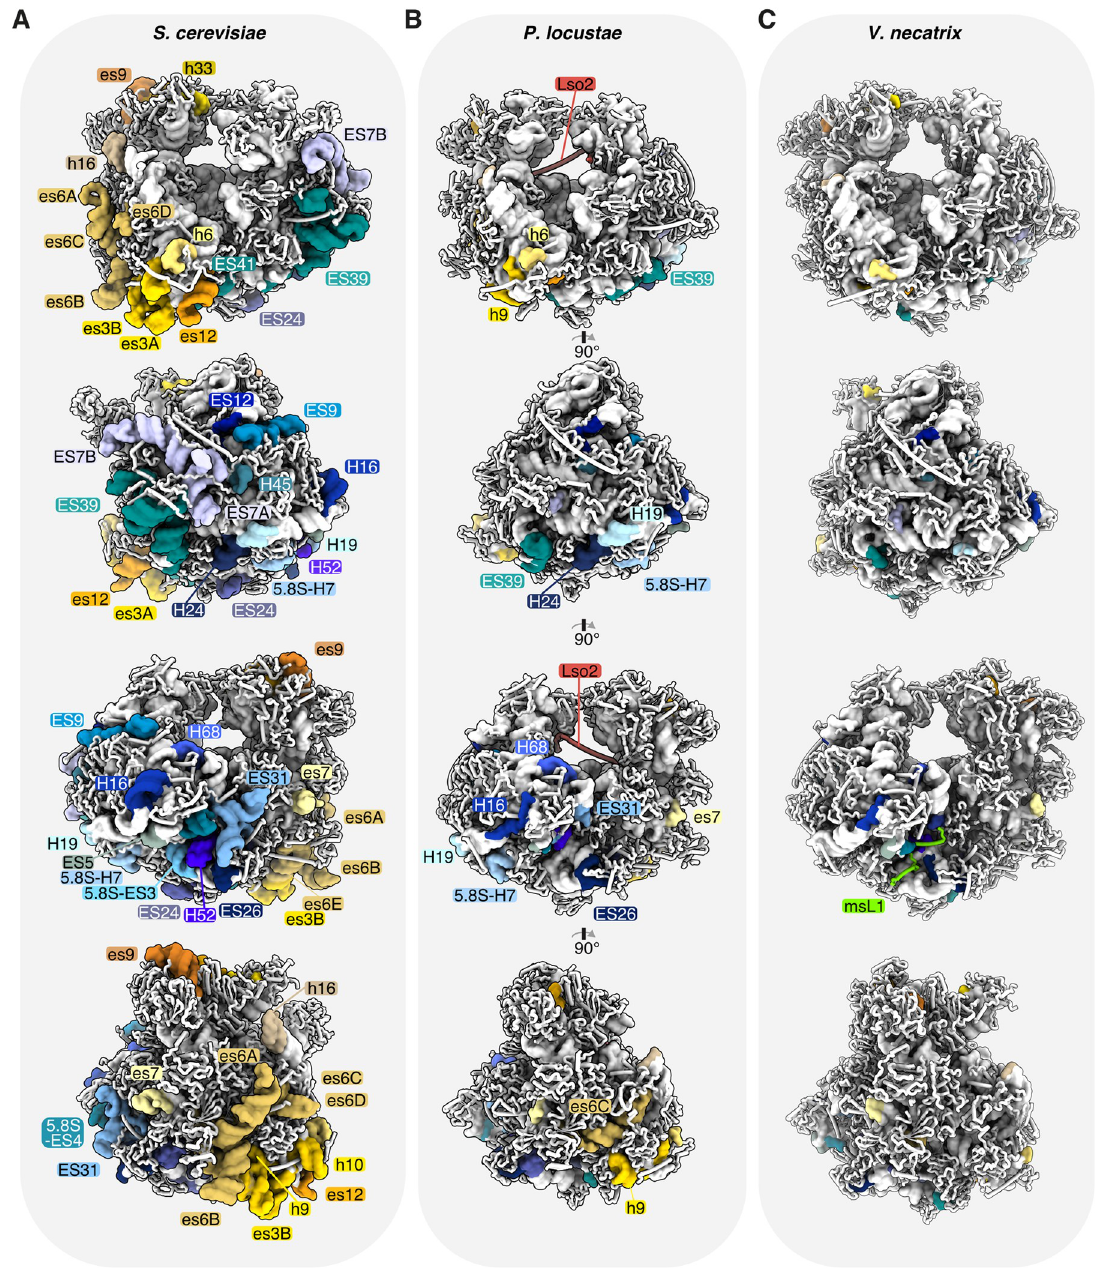
Fig 3. Ribosomal RNA compaction in microsporidia. Comparative analysis of expansion segments and the absence thereof between (A) S . cerevisiae (PDB 4V88), (B) P . locustae (PDB 6ZU5), and (C) V . necatrix (PDB 6RM3). (A–C) Four 90˚-related views of the ribosome are shown (from top to bottom), with expansion segments colored and labeled in shades of yellow and orange (small subunit) or shades of blue and green (large subunit).